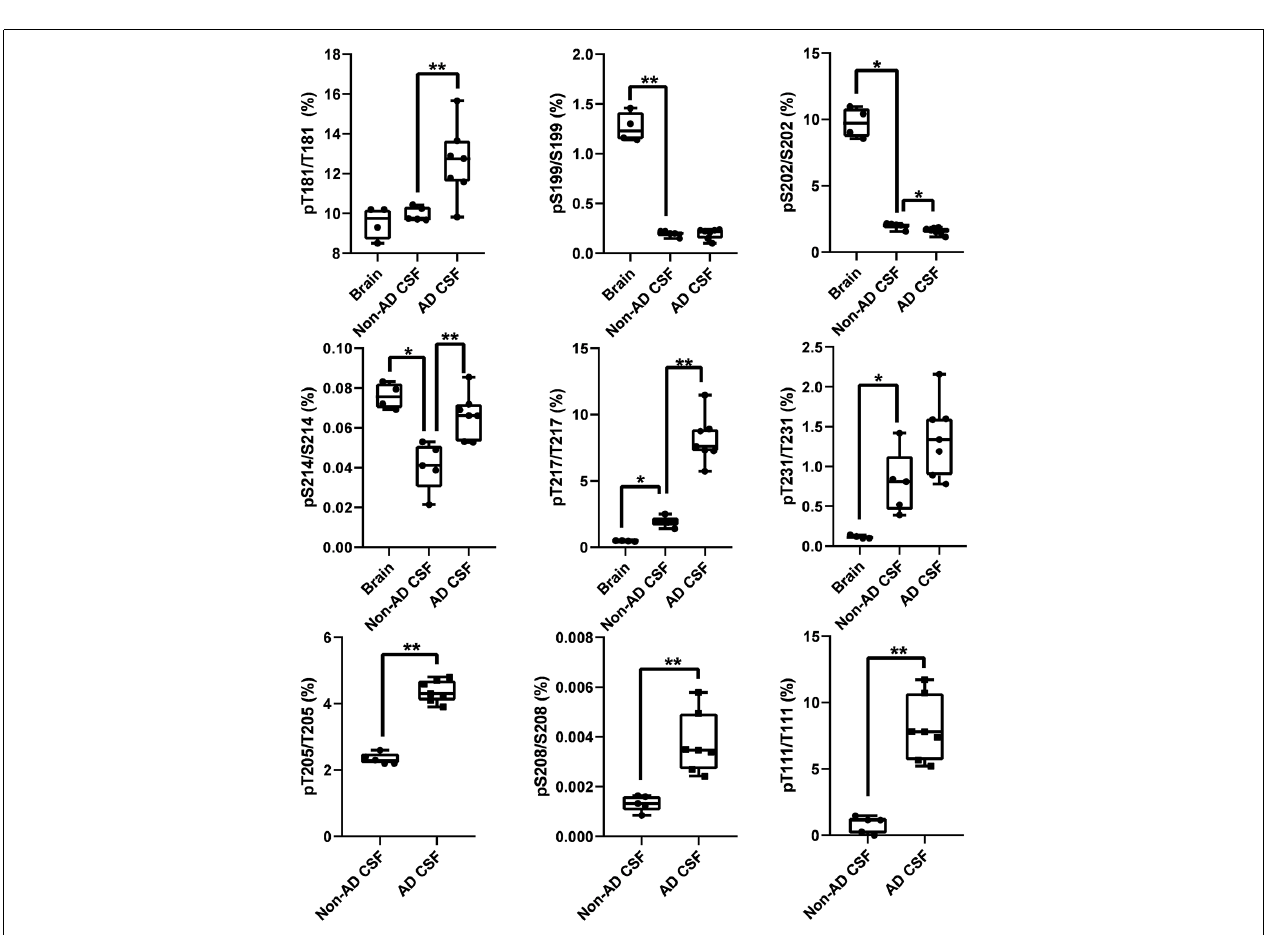
FIGURE 12 | Tau phosphorylation sites are differentially modified in brain, normal CSF and AD CSF. Measurements are the relative abundances of the phosphorylated signal compared to the corresponding nonphosphorylated site (HJ8.5+Tau1 IP-MS). Brain results are obtained from diluted lysates from 500 × to 8,000 × factors to match the CSF tau level. Phosphorylations on T205 and S208 are undetectable in brain tissue. Phosphorylation on T111 is undetectable in 500x diluted lysate but was detected in 10 × diluted lysate with a corresponding abundance of 0.02%. Legend: ∗∗ indicates significance at p = 0.01 level and ∗ indicates significance at p = 0.05